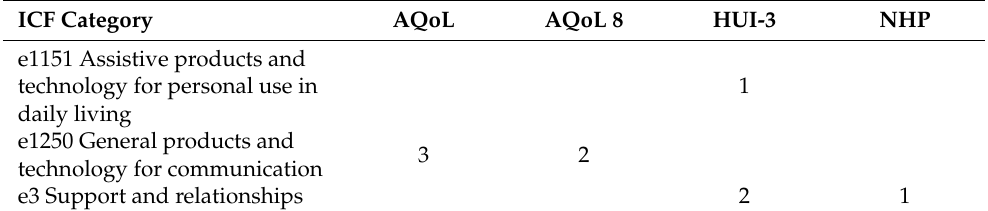
Table 5. Environmental factors categories ICF linking of HRQOL